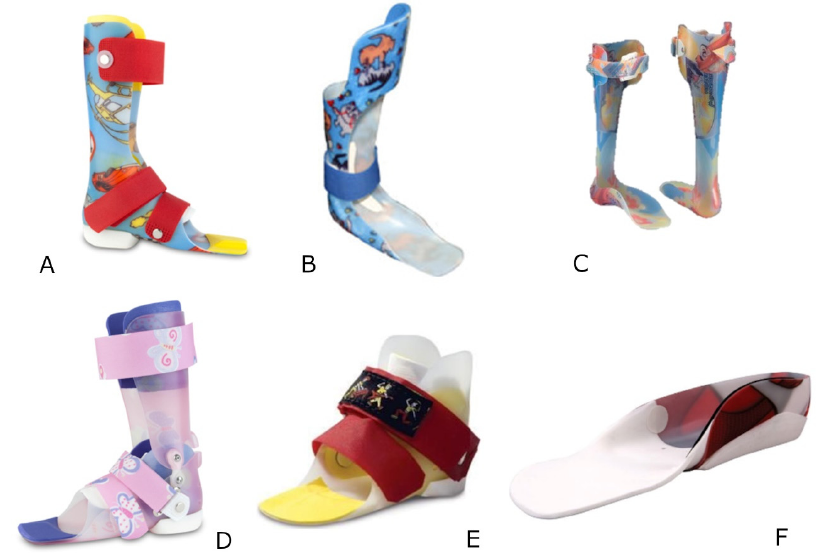
Figure 2. Example of ( A ) solid Ankle Foot Orthosis (AFO), ( B ) ground reaction AFO (GRAFO), ( C ) posterior leaf spring AFO (PLS AFO), ( D ) hinged AFO, € supra-malleolar orthosis, and ( F ) sport dynamic orthosis used in this study.